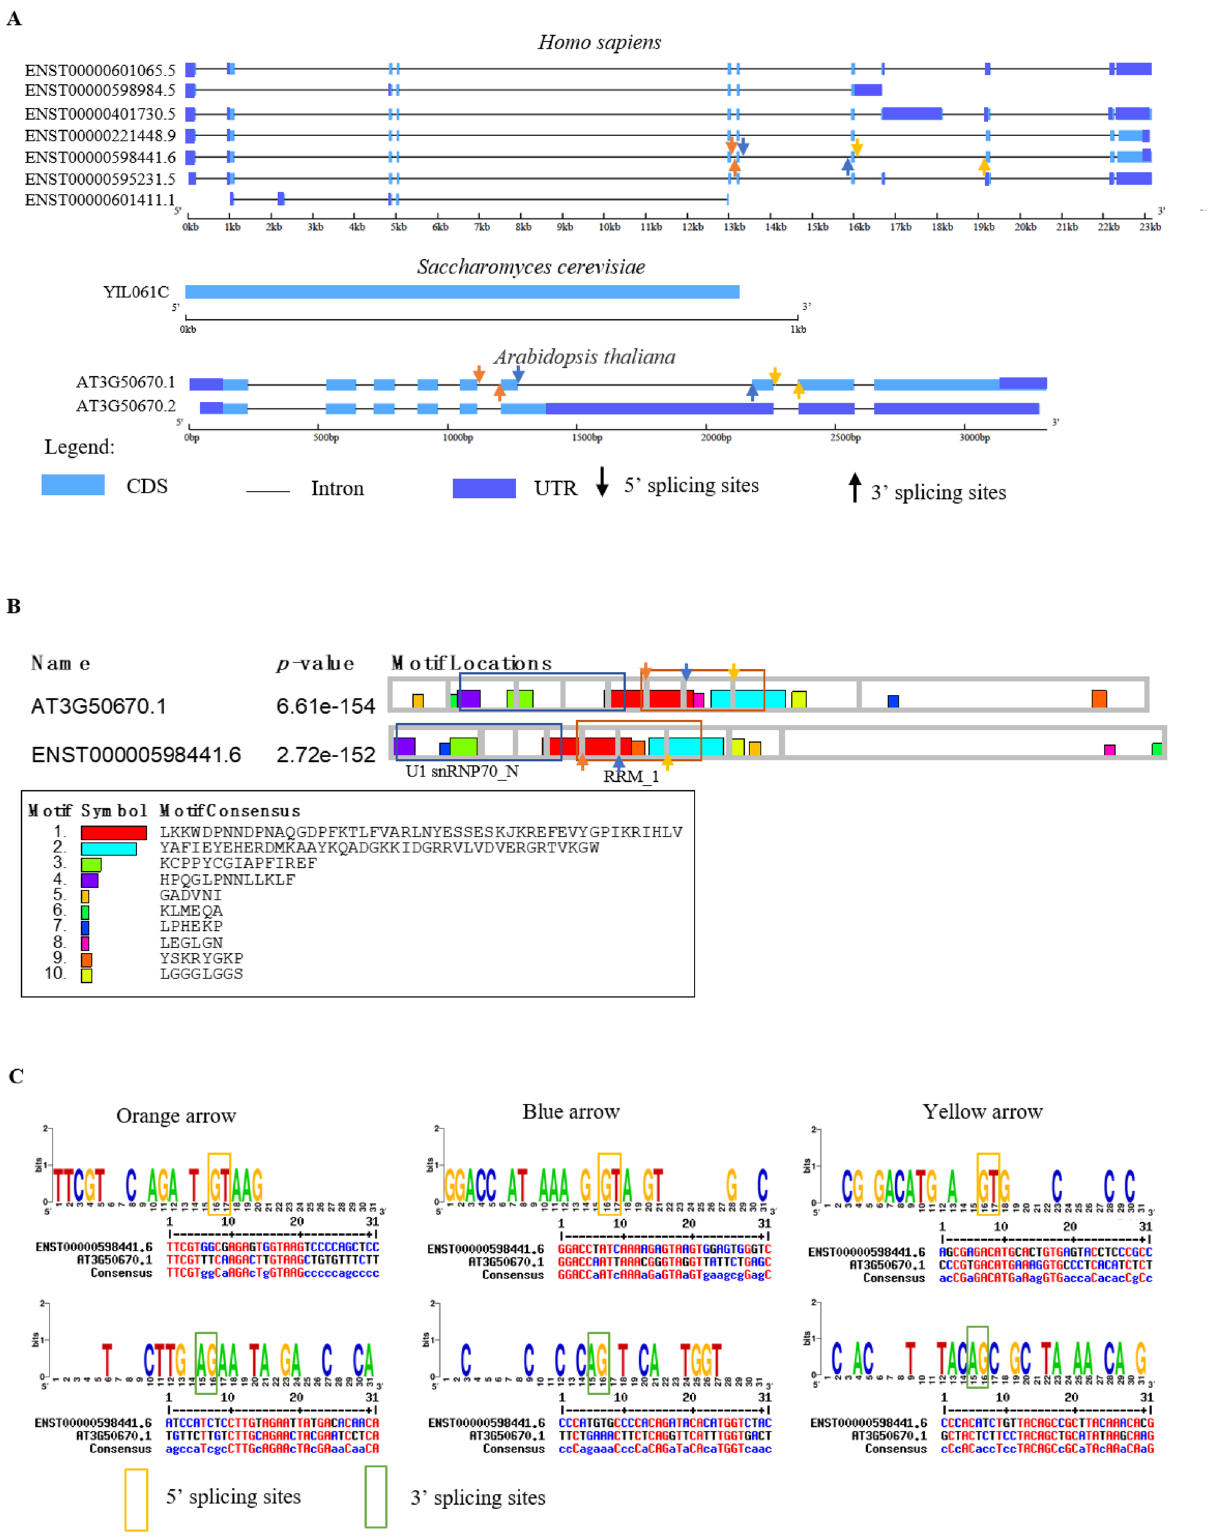
Figure 7. Comparison of U1-70Ks in human, yeast and Arabidopsis. ( A ) Representation of gene structures of U1-70Ks in human, yeast and Arabidopsis. Different colored arrows present different pair of splice sites. ( B ) Conserved motif analysis of human and Arabidopsis U1-70Ks. Grey boxes indicate exon–intron boundaries. ( C ) Conserved splice sites analysis of human and Arabidopsis U1-70Ks. Orange, blue and yellow arrows representing conserved splice sites are shown in left, middle and right panels, respectively. Orange boxes represent 5 ′ splice sites and green boxes represent 3 ′ splice